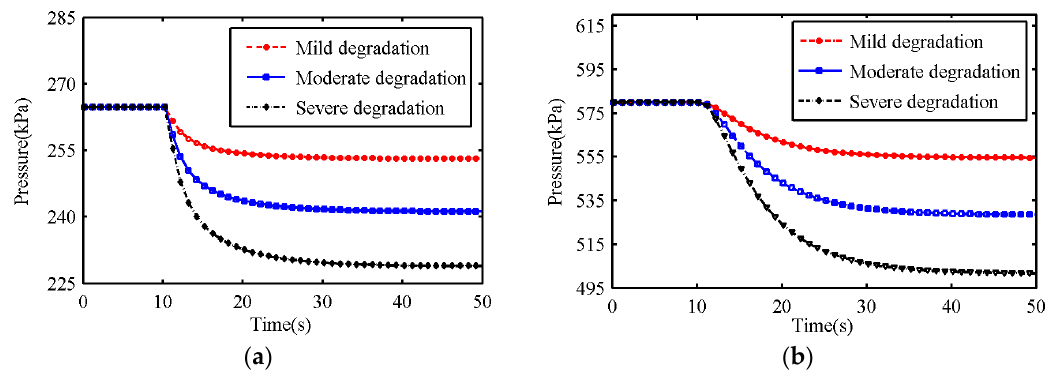
Figure 9. Valve plate, actuator displacement, and cylinder pressure under different spring stiffness values.